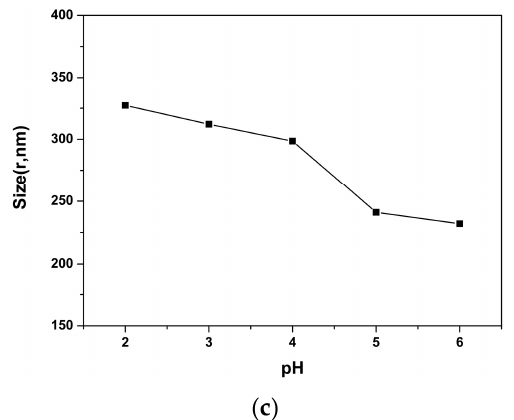
Figure 4. Dynamic light scattering (DLS) histogram of mPEG 43 -PMCC 25 -P(MCC-DHO) 15 in water at ( a ) pH = 2.0 and ( b ) pH = 6.0, ( c ) size of mPEG 43 -PMCC 25 -P(MCC-DHO) 15 in various pH at 25 °C.